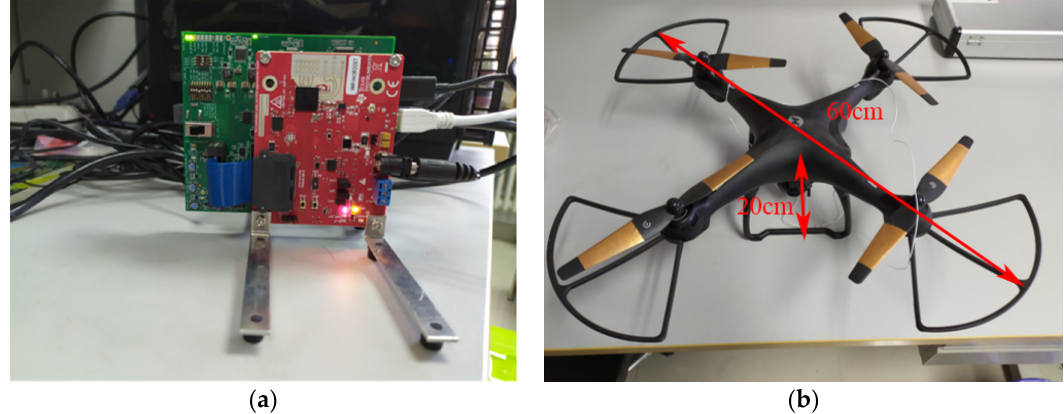
Figure 13. Radar system and target: ( a ) the InISAR system; ( b ) the rotating target.